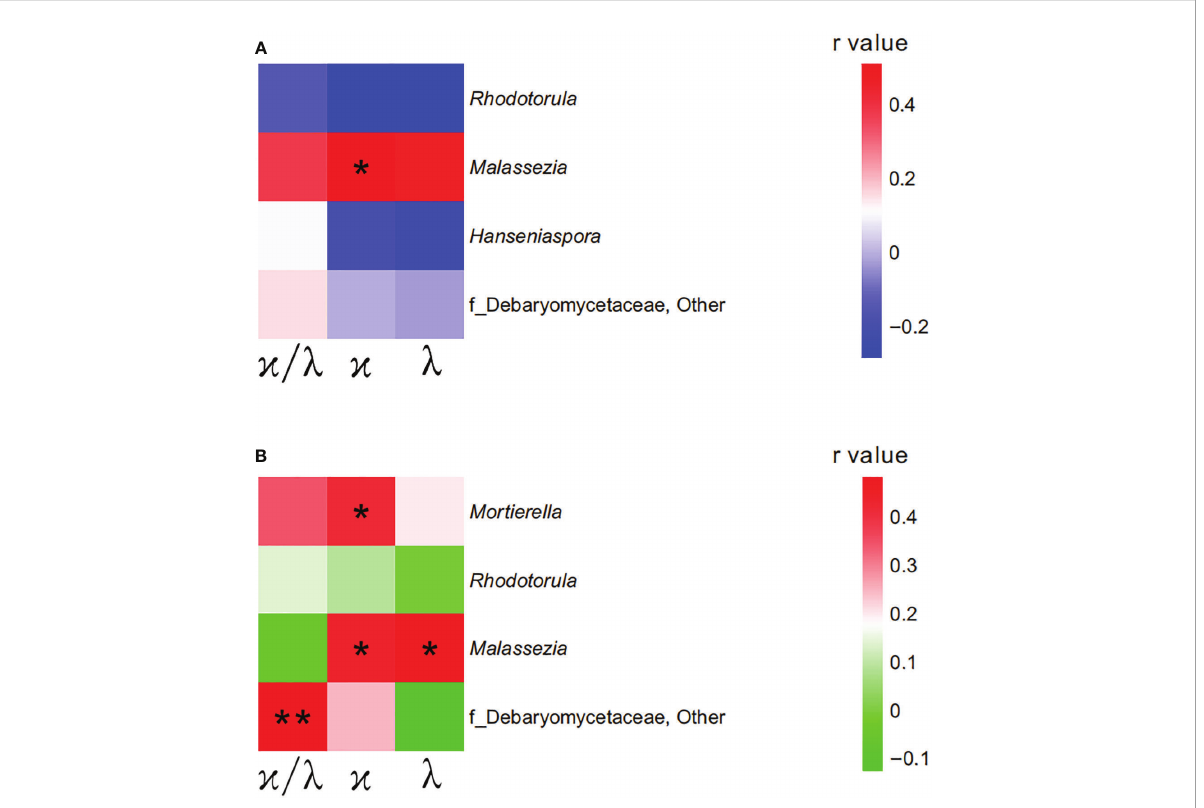
FIGURE 3 Mycobiome was associated with participants ’ immunoglobulin light chains. (A) The heatmap depicted the association between the bacterial genera and immunoglobulin light chains showing differed in pre-HTN compared to NT. (B) The heatmap depicted the association between the bacterial genera and immunoglobulin light chains showing differed in HTN compared to NT. Pearson correlation analysis was performed. The correlation of two variables with values of | r |>0.3 and P< 0.05 are displayed. * P< 0.05; and ** P<